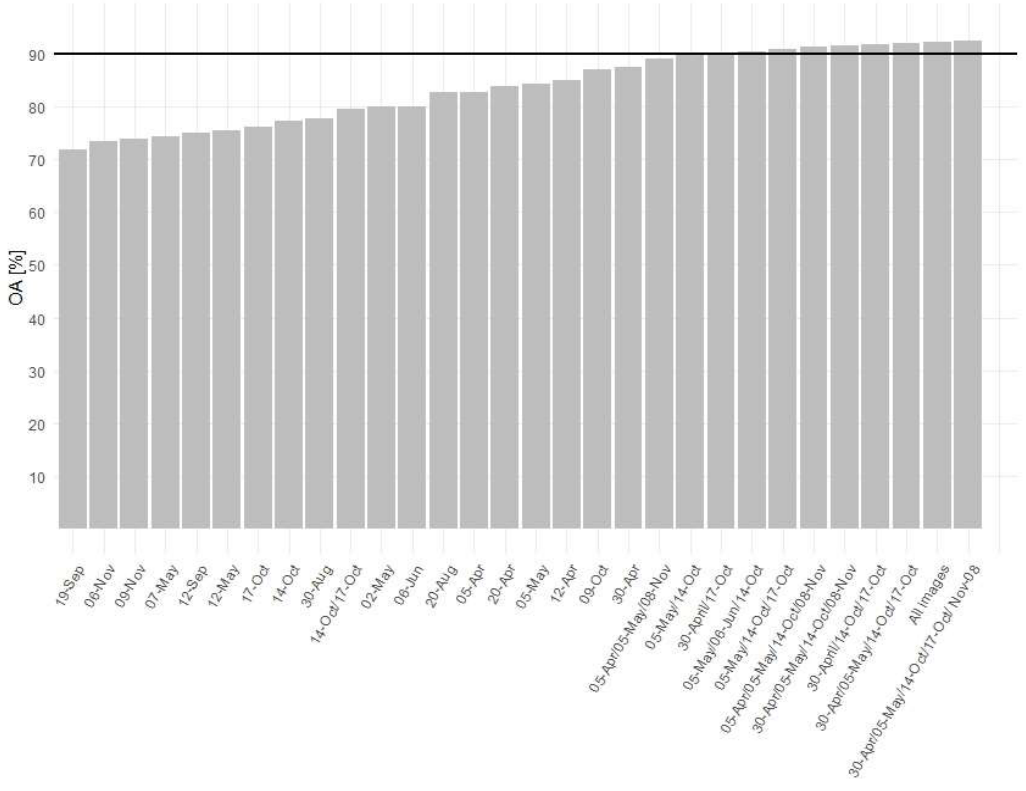
Figure 7. Overall classification accuracy for single Sentinel-2 images and selected combinations of time series.